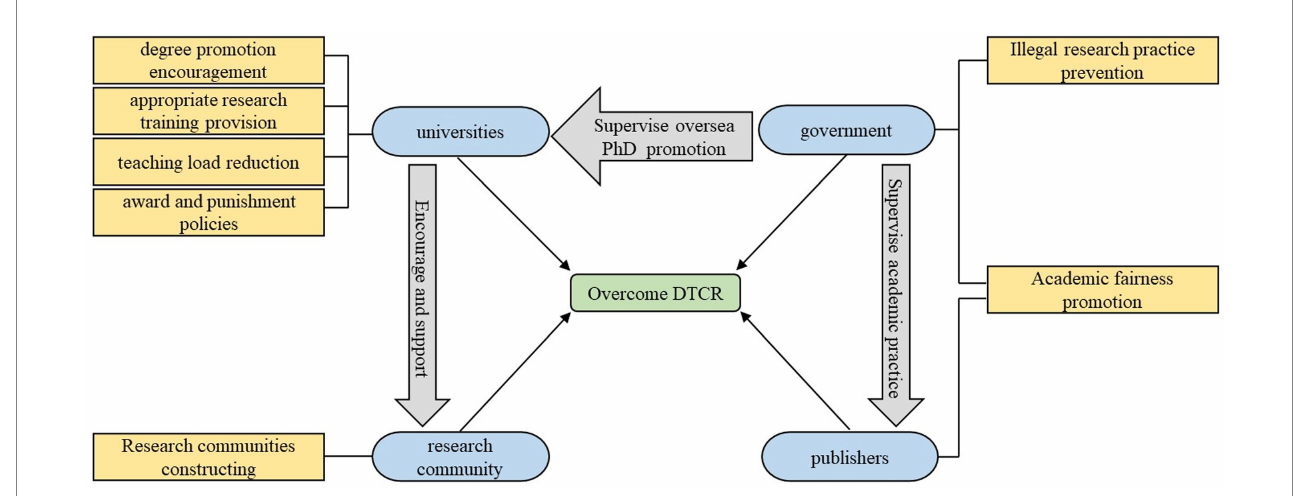
FIGURE. 3 Mind map for thematic analysis